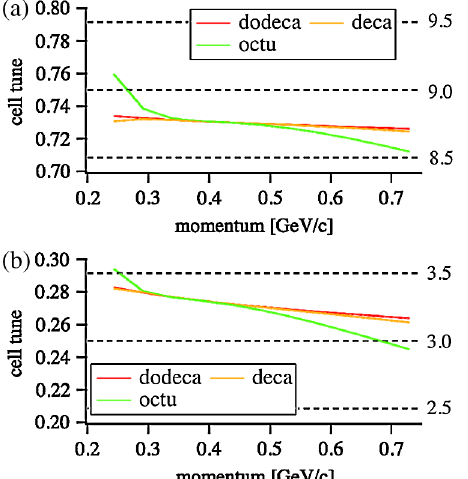
FIG. 6. (Color) Cell tunes throughout acceleration for the case of rectangular-shaped magnets with different order of truncation. Three magnets face the machine center as in Fig. 5. The horizontal cell tune is shown in (a) and the vertical cell tune in (b). Dashed lines and associated numbers show total tune of a 12 cell